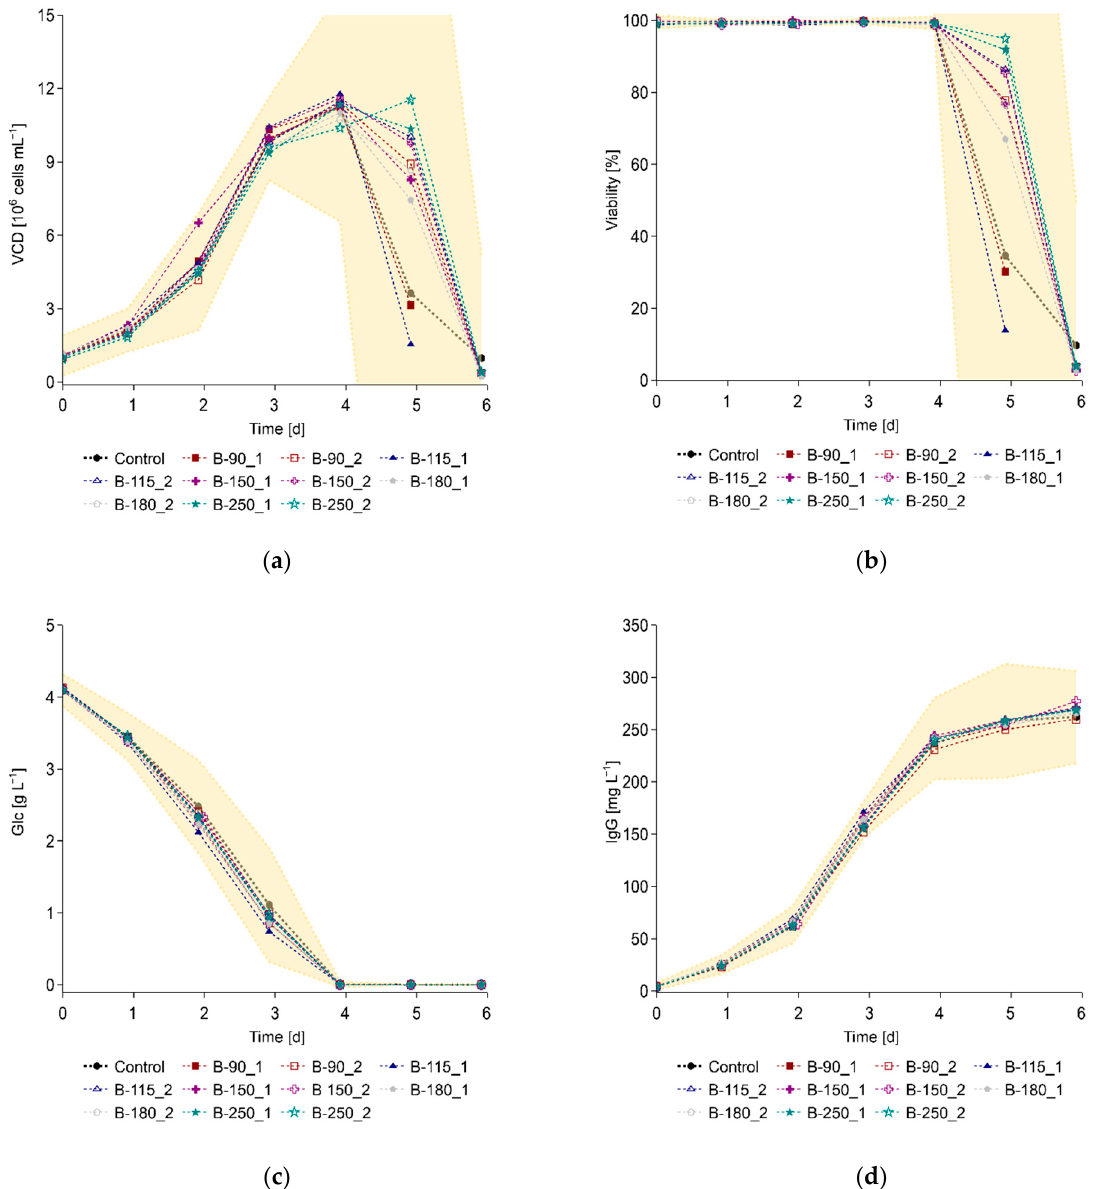
Figure 4. Course of ( a ) VCD, ( b ) viability, ( c ) glucose (Glc), and ( d ) IgG concentration during the batch experiments inoculated directly from cryovials containing high VCDs from 90 to 250 × 10 6 cells mL − 1 (nomenclature: B = Batch, 90/115/150/180/250 = VCD in cryovial (×10 6 cells mL − 1 )). Control: batch experiments inoculated directly from cryovials containing lower VCDs (15–40 × 10 6 cells mL − 1 , n = 3). Growth was independent of the freezing VCD until day 4. Growth rates from day 0 to day 3 ranged from 0.0310 ± 0.0027 h − 1 for the batch experiments inoculated from cryovials containing 180 × 10 6 cells mL − 1 to 0.0325 ± 0.0023 h − 1 for the batch experiments inoculated from cryovials containing 90 × 10 6 cells mL − 1 . Viability remained >98% in all shake